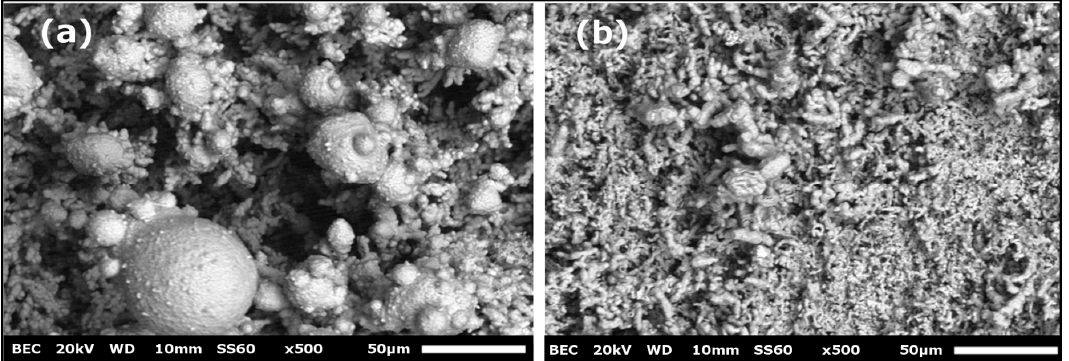
Figure 7. Zoom of 500× on the film of ( a ) ZnO, and ( b ) ZnO:Ta doped with 300 mg of Ta 2 O 5 on pellet.